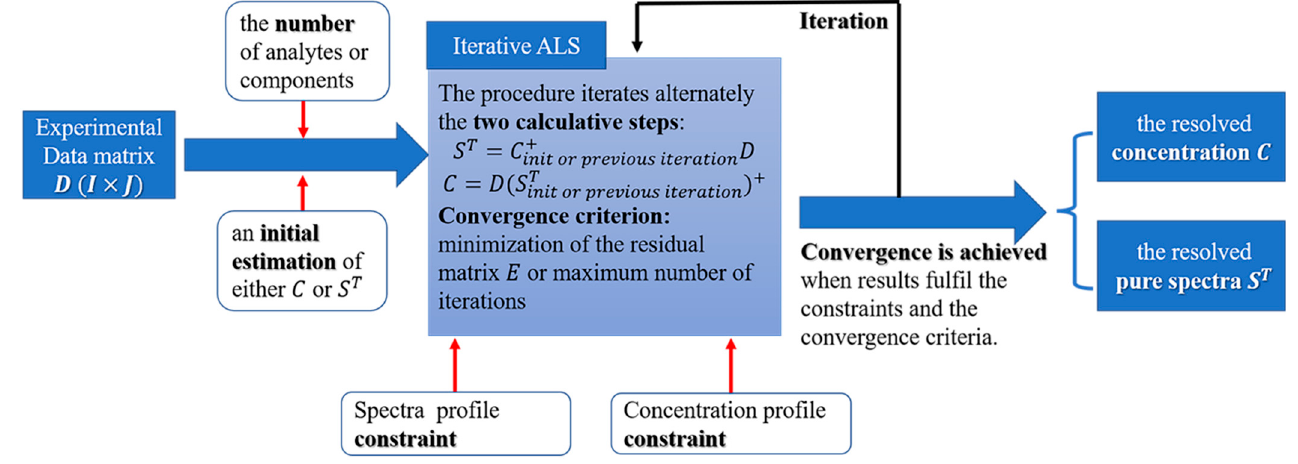
Figure 1. Flowchart of steps of the resolution process in the MCR-ALS method. Iterations continue until convergence is achieved, i.e., when, in two successive iterative cycles, the relative divergence in the standard deviations of the residuals between experimental and ALS calculated data values is less than a previously ascertained value (usually set to 0.1%) or the maximum number of iterations is reached [38]. The performance of the iterative ALS procedure is evaluated by 3 parameters: the percent of lack of fit (LOF), the percent of variance explained (EV), and the standard deviation of residuals with